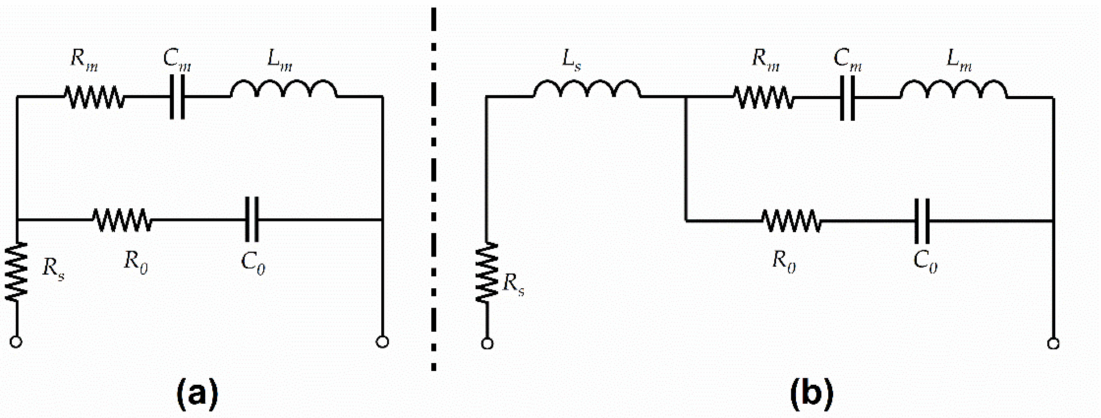
Figure 7. ( a ) Equivalent circuit of the single acoustic resonator by the MBVD model; ( b ) Equivalent circuit of the acoustic resonator connected in series with the inductor L s